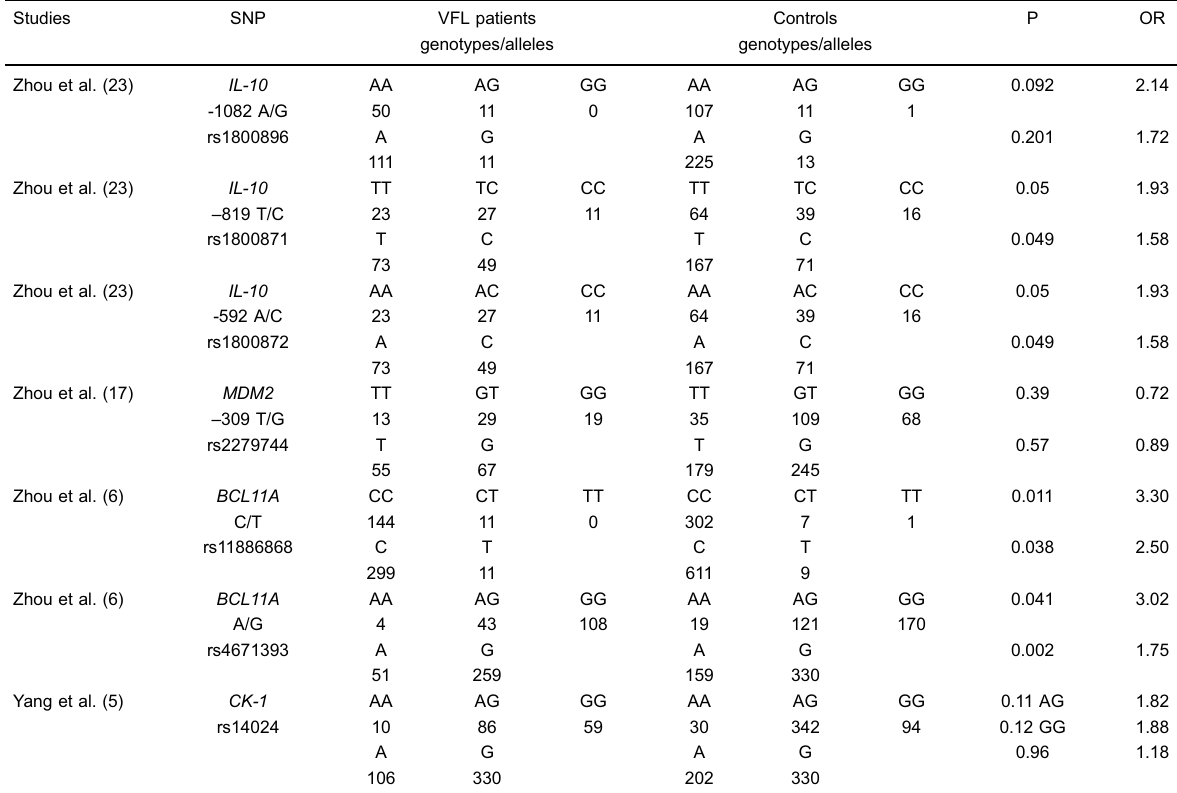
Table 3. Distribution of genotypes and alleles for polymorphisms in cases and controls.